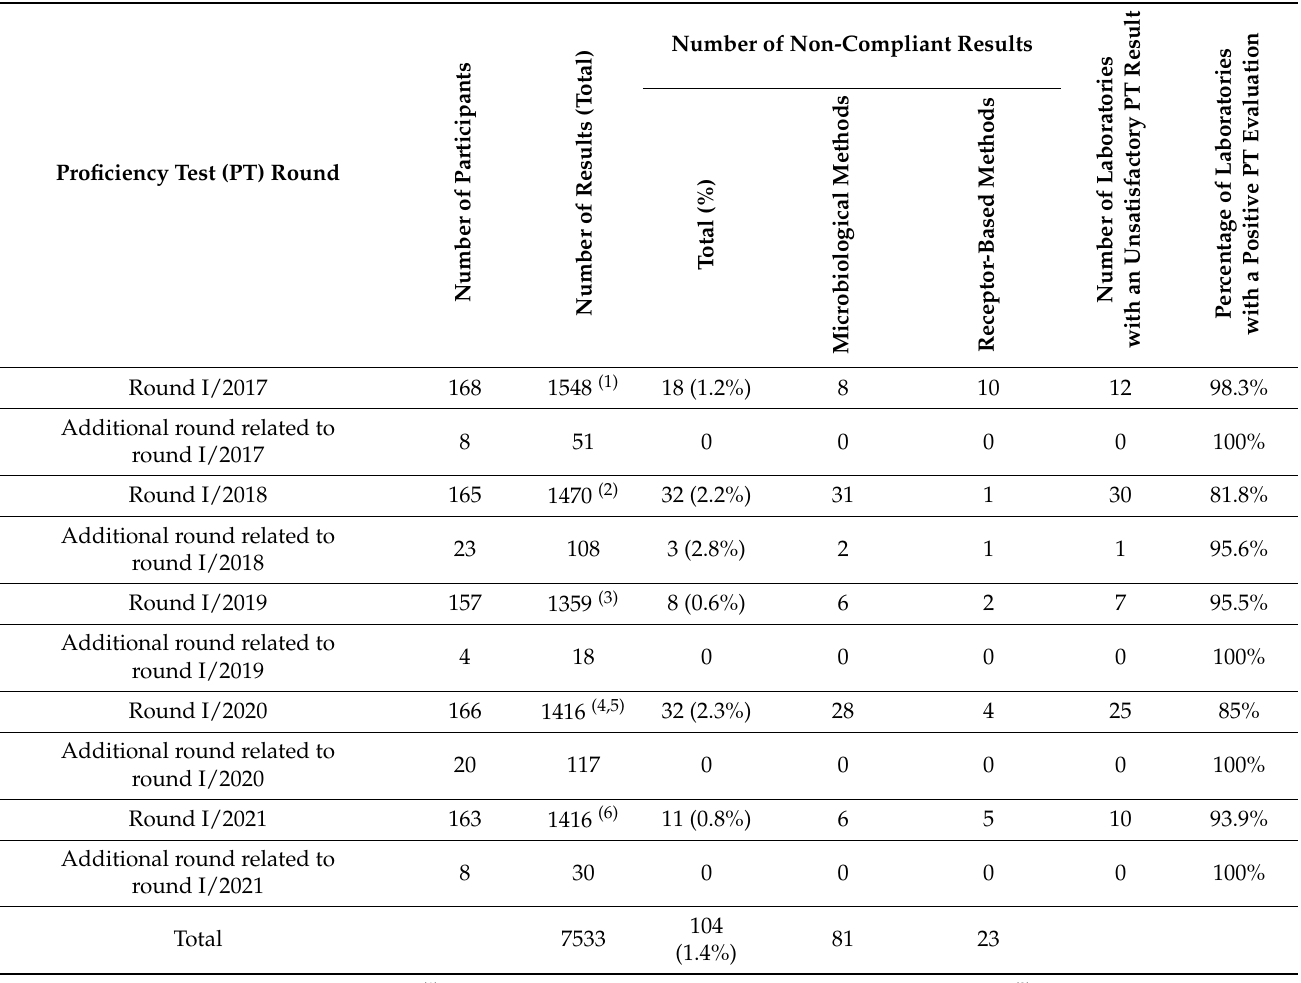
Table 2. Summary of proficiency test results in